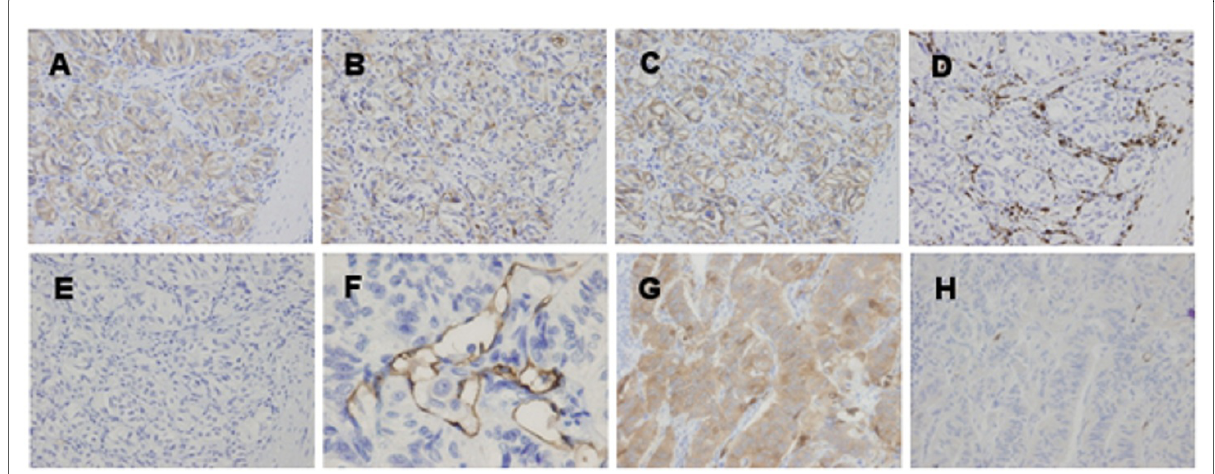
Figure 3 Photomicrographs showing representative immunohistochemistry . (A, B, and C) Epithelioid cells showed positive reactivity for synap- tophysin, somatostatin, and CD56 (× 400). (D) Spindle-shaped cells showed positive reactivity for S-100 protein (× 400). (E) Tumor cells of both types showed negative reactivity for chromogranin A (× 400). (F) Tumor cells invade into the lymphatic lumen (immunohistochemistry with podoplanin